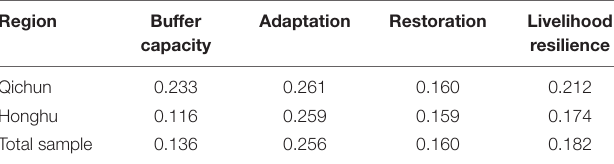
TABLE 2 | Livelihood resilience